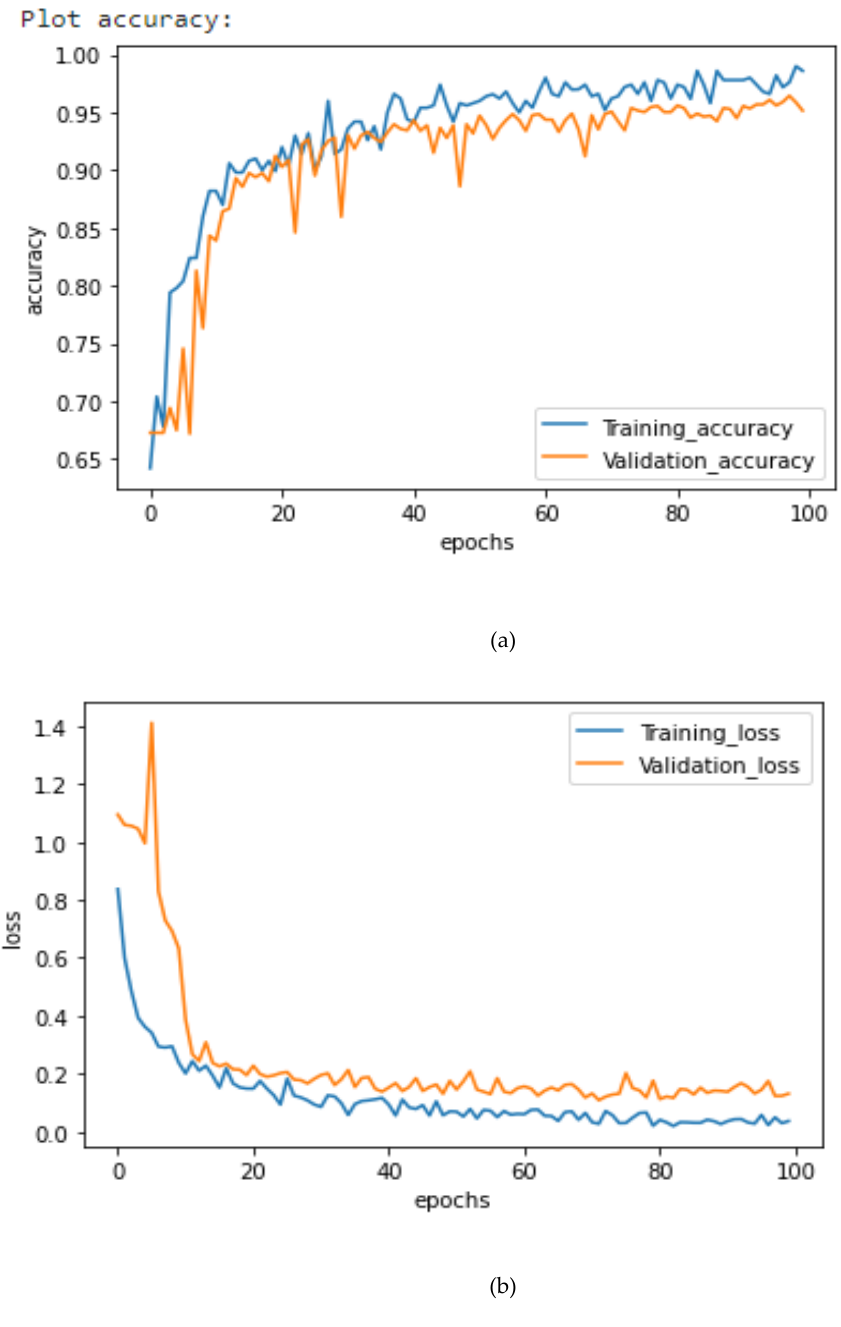
Figure 7. Xception Loss and Accuracy curves. ( a ) Training and Validation Accuracy, ( b ) Training and Validation Loss.